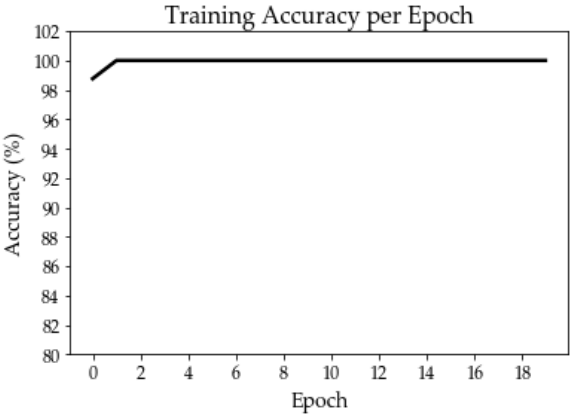
Figure 8. Classifier training for reverse validation.